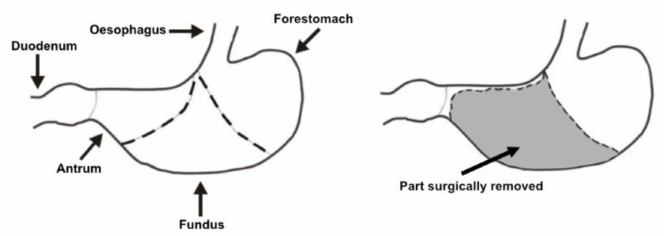
Figure 1. Schematic presentation of the performed modified